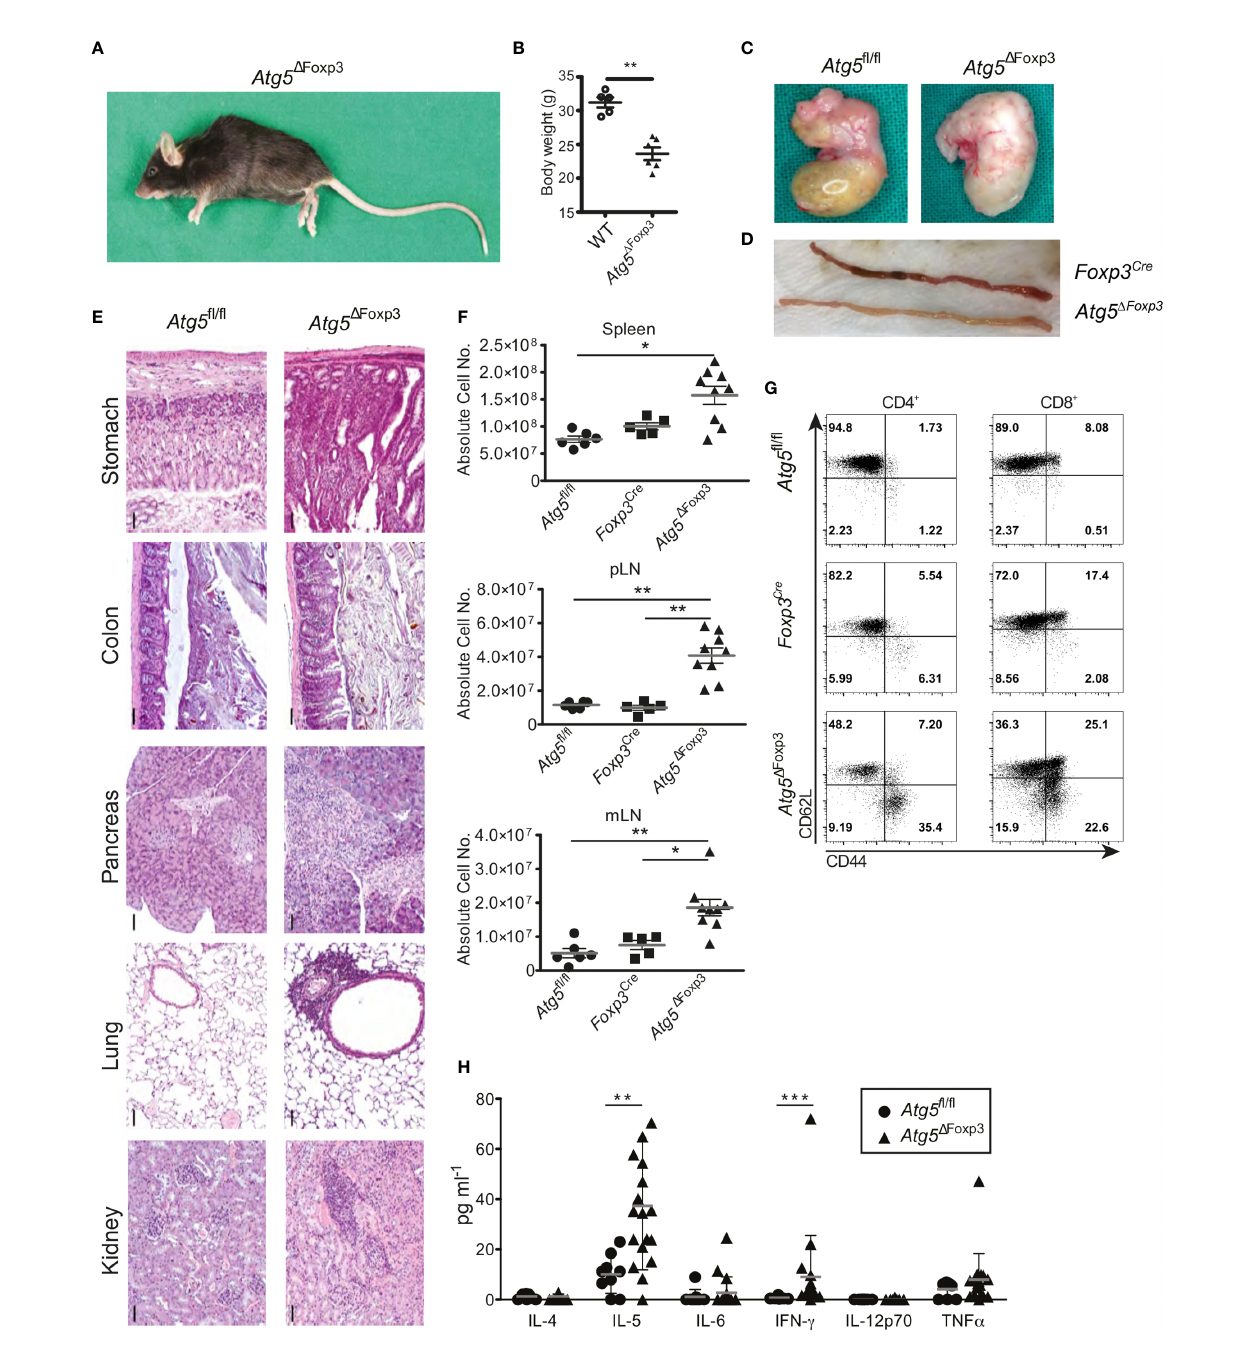
FIGURE 3 | Mature Atg5 D Foxp3 mice develop systemic in fl ammation. (A) Picture of a 22-week-old Atg5 D Foxp3 mouse. (B) Body weight of Atg5 D Foxp3 and BL6 (control) mice at the age of 22 weeks. (C) Stomach pictures of Atg5 fl / fl (left) and Atg5 D Foxp3 (right) mice. (D) Picture of the small intestine from Foxp3 Cre and Atg5 D Foxp3 mice. (E) Representative histological sections of paraf fi n-embedded tissue from kidney, lung, pancreas, colon and stomach of 22-week-old Atg5 fl / fl and Atg5 D Foxp3 mice stained with hematoxylin and eosin. Bar size: 50 µm (F) Absolute cell numbers of spleen, peripheral lymph nodes (pLN) and mesenteric lymph nodes (mLN) from 11-20-week-old Atg5 fl / fl , Foxp3 Cre and Atg5 D Foxp3 mice. Mean ± SEM are given. The Kruskal – Wallis one-way ANOVA tests were used for statistical analysis. Each symbol represents a single mouse in scatter plots. (G) Representative dot plots of T cell activation markers CD44 and CD62L in CD4 + Foxp3 - and CD8 + cells from peripheral lymph nodes of 11-20-week-old Foxp3 Cre and Atg5 D Foxp3 mice (n=4 Foxp3 Cre and n=8 Atg5 D Foxp3 mice). (H) Cytokine concentrations in sera from 11-20-week-old Atg5 fl / fl and Atg5 D Foxp3 mice measured by Luminex ® technology. (B, H) Statistical analyses were performed by two- tailed Mann-Whitney tests. *p < 0.05, **p < 0.01, ***p <